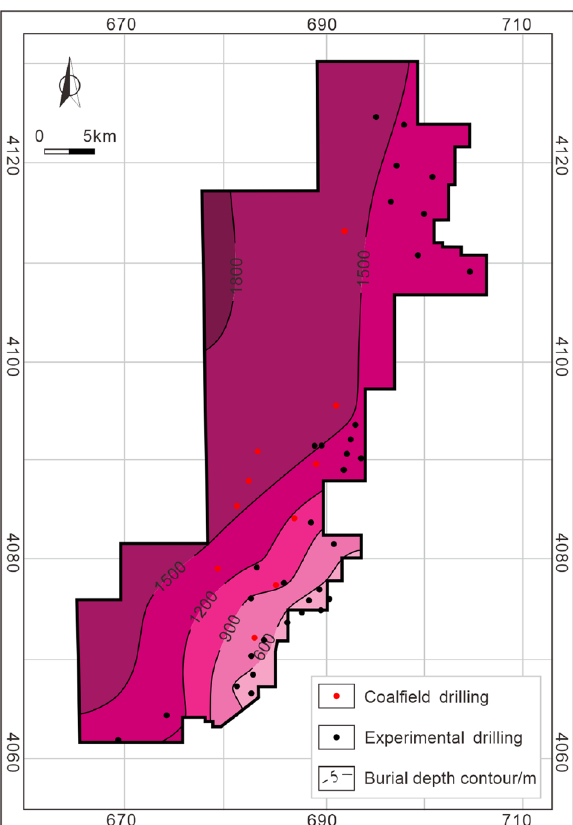
Figure 7. Burial depth contour of the Taiyuan Formation in the study